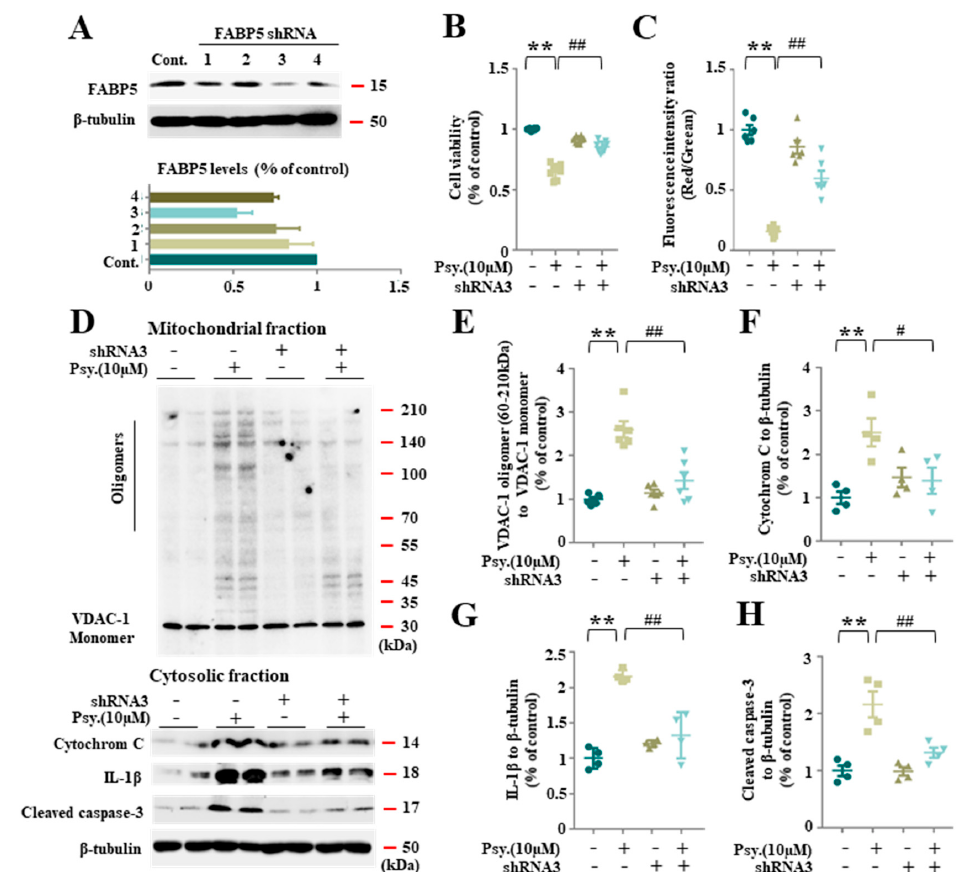
Figure 4. FABP5 inhibition by shRNA reduced mitochondria pore formation. ( A ) Western blot analysis of FABP5 in shRNA transduction KG-1C cells (top), bar graph showing shRNA 3 was the most efficient one (bottom). ( B ) Cell viability analysis of KG-1C, based on CCK assay. KG-1C cells were treated with psychosine (10 µM) or shRNA. We observed a rescue in cell viability in shRNA- treated cells ( n = 8). ( C ) Analysis of mitochondrial membrane potential by JC-1 assay. KG-1C cells